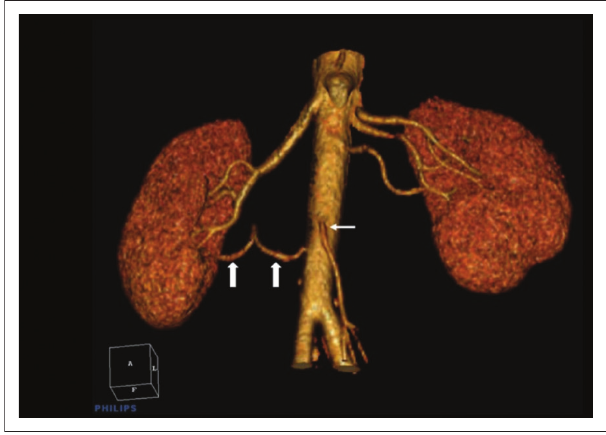
FIGURE 5: Accessory renal arteries – three-dimensional volume rendered image shows two renal arteries on the right – there is an accessory inferior polar artery (thick arrows) arising from the aorta below the inferior mesenteric artery (thin arrow). There are three renal arteries on the